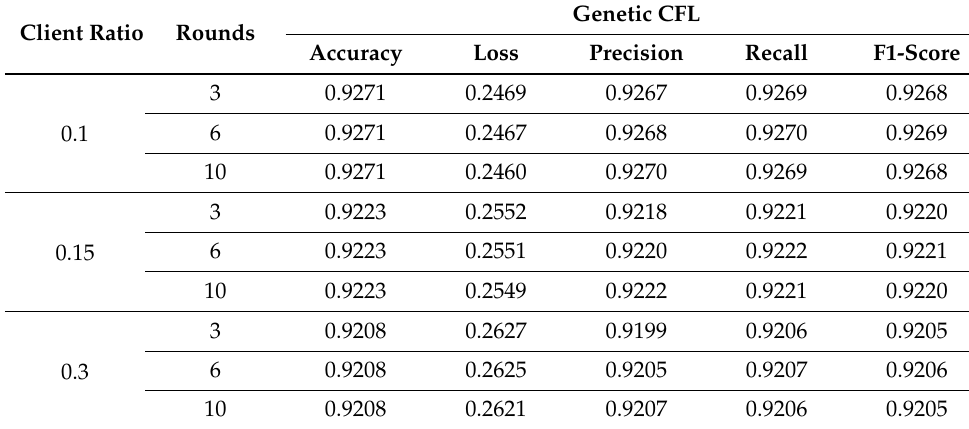
Table 5. Comparison of the performance of genetic CFL on various hyper-parameters on the COVID test